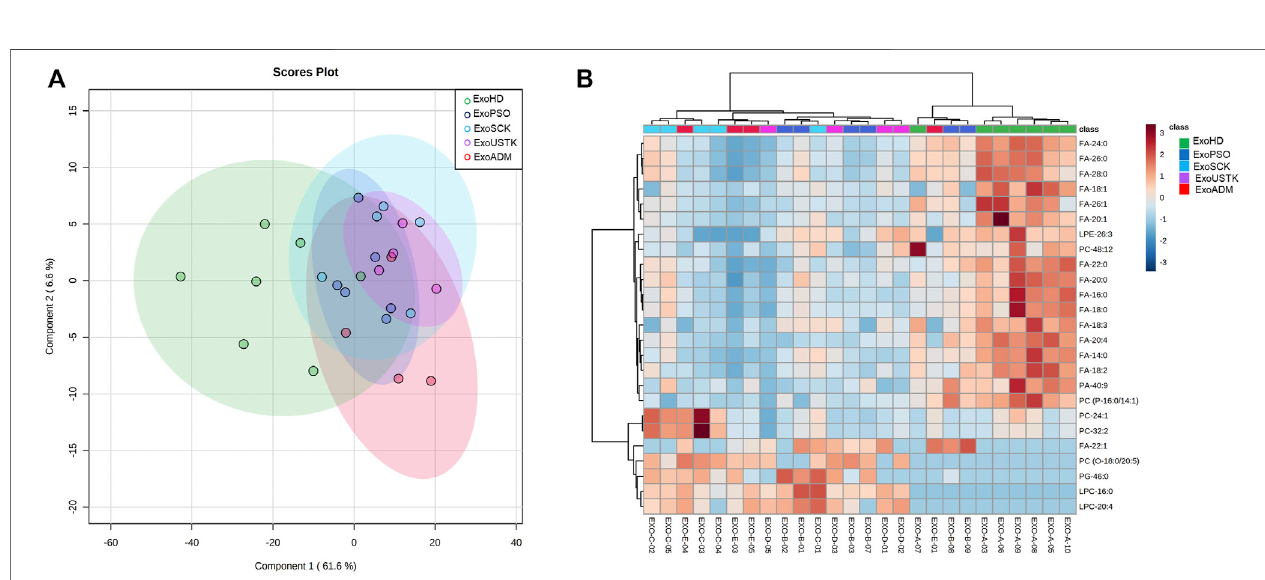
FIGURE5| ChemometricandclusteringanalysisofExolipidome. (A) PLS-DAof fi veexperimentalgroupsbasedonthewholelipiddataaftermediannormalization and Pareto scaling. CI 95% ellipses are shown for the fi ve different groups. (B) Heatmap of 25 most signi fi cant (ANOVA) lipids. Lipids and samples were both ordered using hierarchical clustering (Pearson distance). Autoscaled relative abundances of lipid species is represented by graduation of color from red (more abundant) to blue (less abundant).